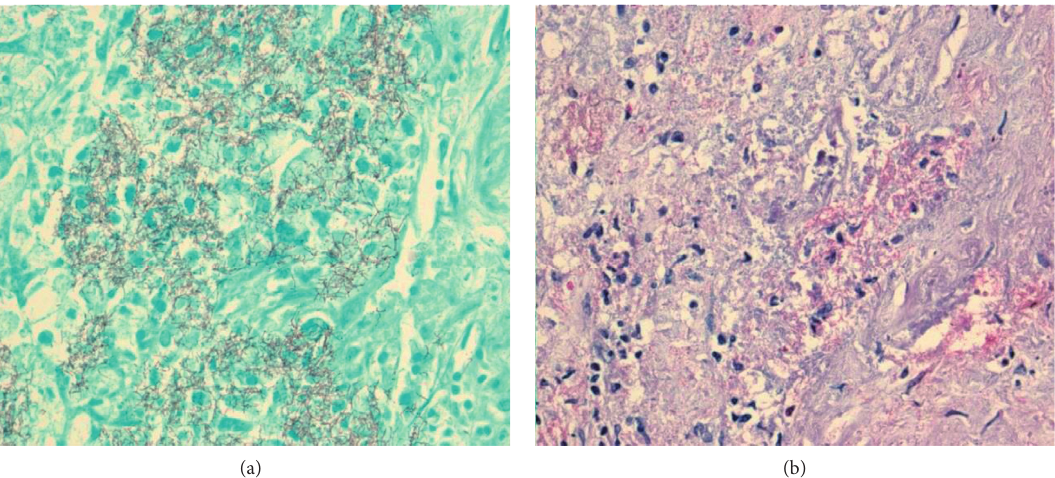
Figure 7: Autopsy: cerebral nocardiosis. GMS (a) and FITE (b)